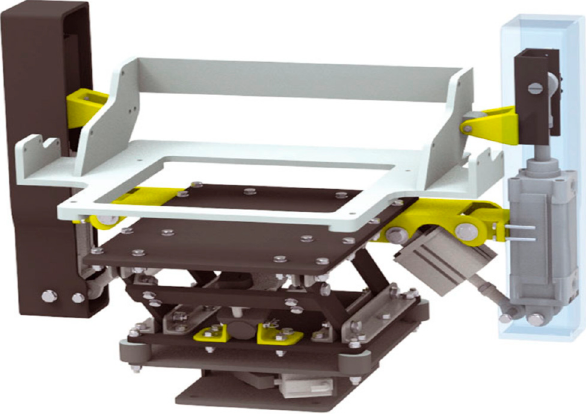
Figure 4. CAD model of the seating suspension structure [43].